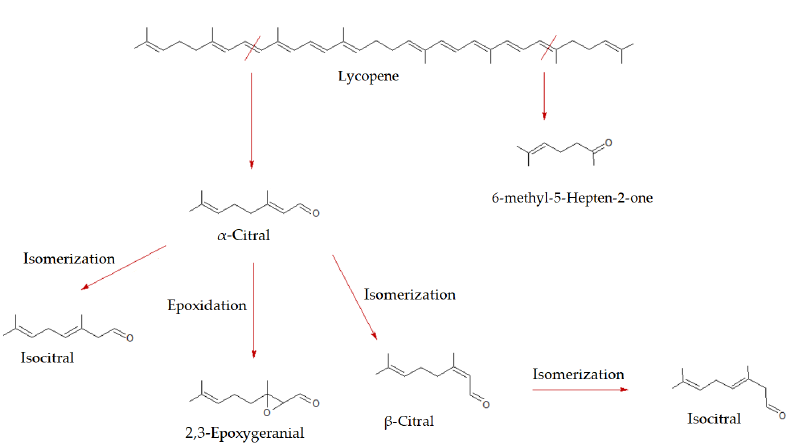
Figure 6. Proposed biosynthetic pathway for watermelon volatiles and their counterpart: lycopene